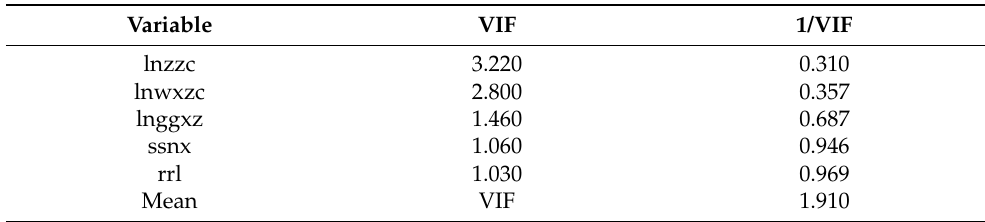
Table 3. Variance inflation